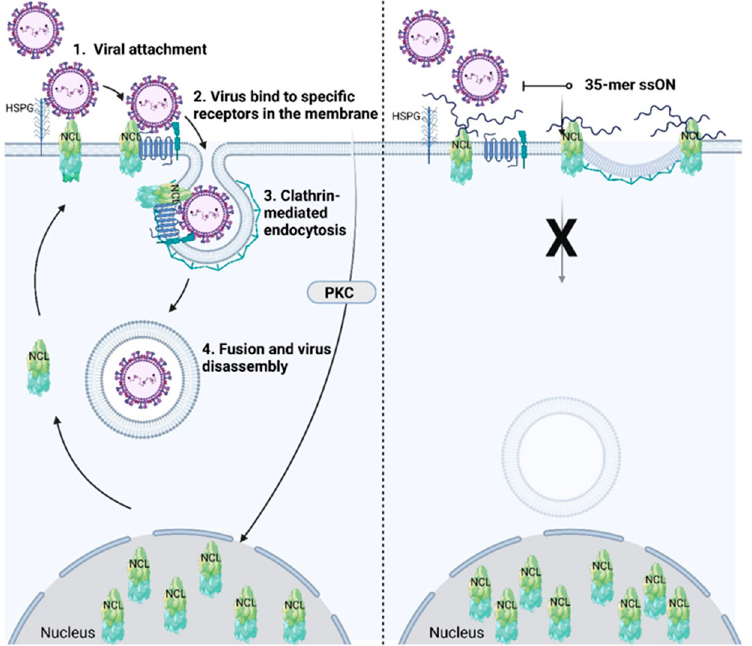
Figure 4. Schematic illustration of nucleolin (NCL) as a receptor for viruses and its participation in clathrin-mediated endocytosis ( left ), which can be inhibited by 35-mer ssON ( right ). Viruses attach to the cellular membrane using, e.g., heparan sulfate proteoglycan and/or NCL, followed by clathrin-mediated endocytosis. 35-mer ssON, but not 15-mer ssON, can inhibit viral attachment by shielding NCL. 35-mer ssON is hypothesized to confer steric hindrance for endocytosis. Reproduced from